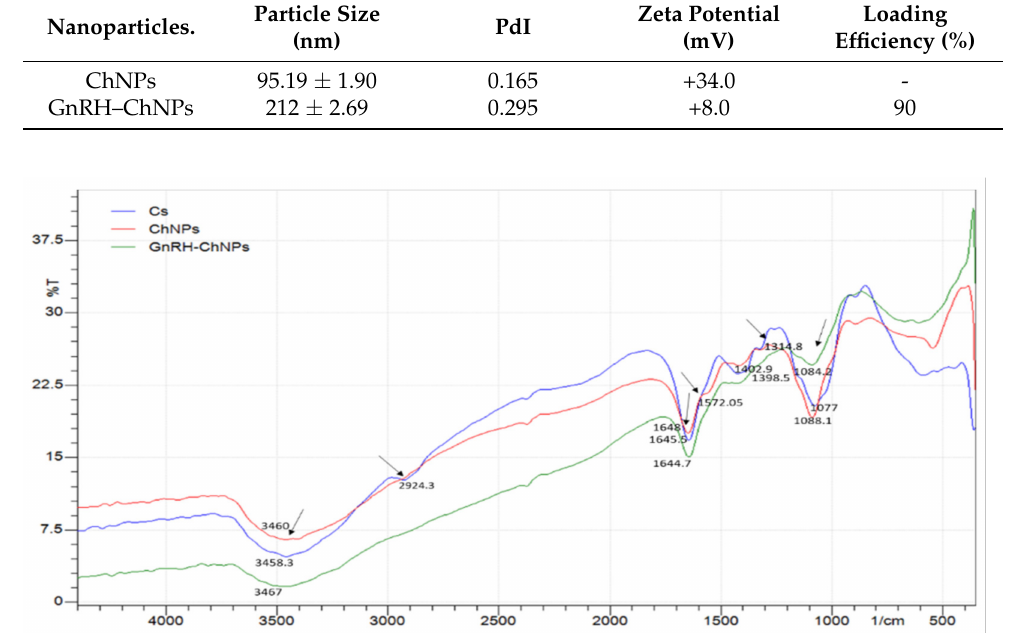
Figure 3. Fourier transform infrared (FTIR) spectra of chitosan (Ch), chitosan-TPP nanoparticles